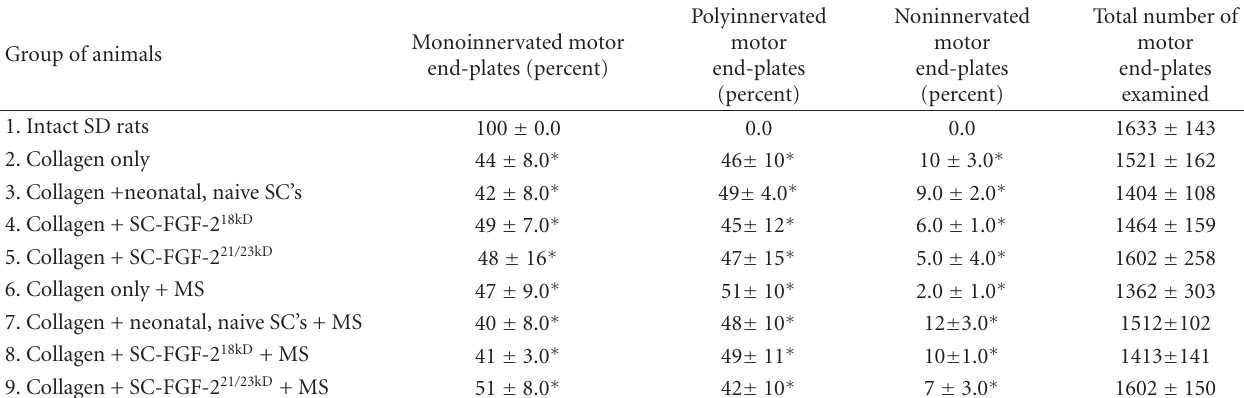
Table 3: Quality of target muscle reinnervation. Reinnervation pattern of the levator labii superioris motor-end plates in intact rats, in rats after transection of the right facial nery followed by:- entubulation with collagen only, with collagen plus naive SC’s, or with collagen plus genetically modified SC’s. In group 6–9 entubulations were followed by manual mechanical stimulation (MS) of the vibrissal muscles. Motor endplates were classified a monoinnervated, polyinnervated, or noninnervated according to the number of beta-tubulin-immunoreactive axons that crossed th boundaries of the